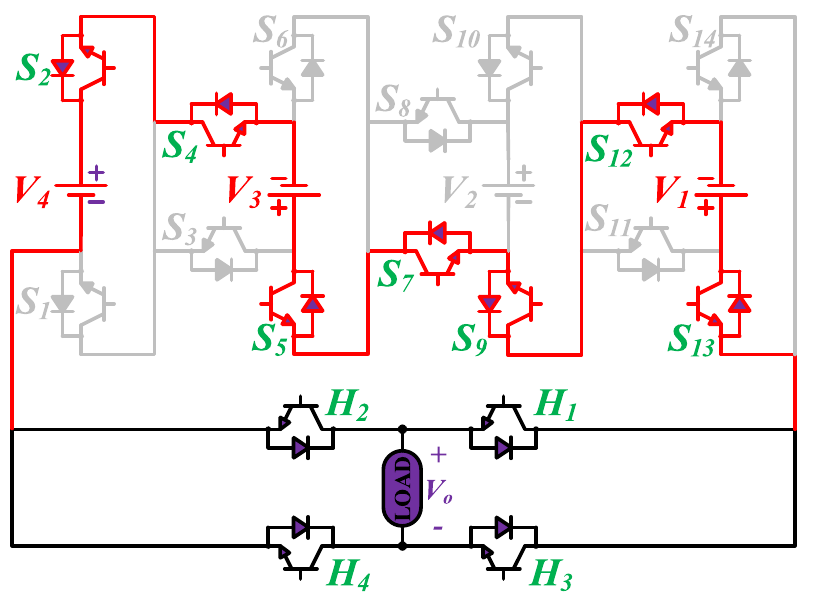
Fig 12. Switching states for voltage magnitude level 37.